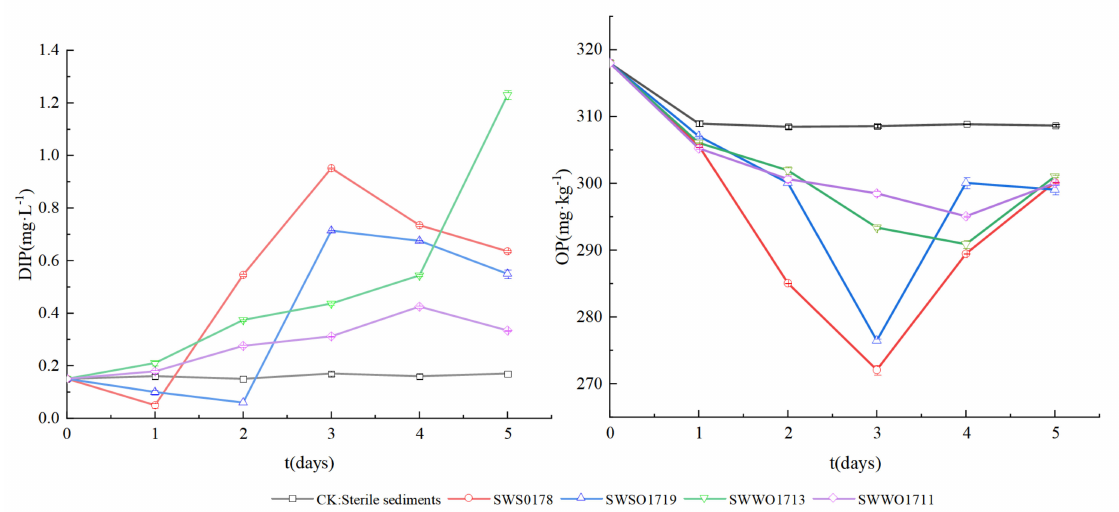
Figure 5. Solubilizing effect of four representative strains in sterilized sediments. Note: growing broth at 13 ◦ C after 1, 2, 3, 4, and 5 days of growth. The DIP contents in the overlying water. The OP contents in the sediments. Each value is a mean of 3 independent replicates. CK: uninoculated control. The strains of SWSO178, SWSO1719, SWWO1713, and SWWO1711 indicate treatments inoculated,